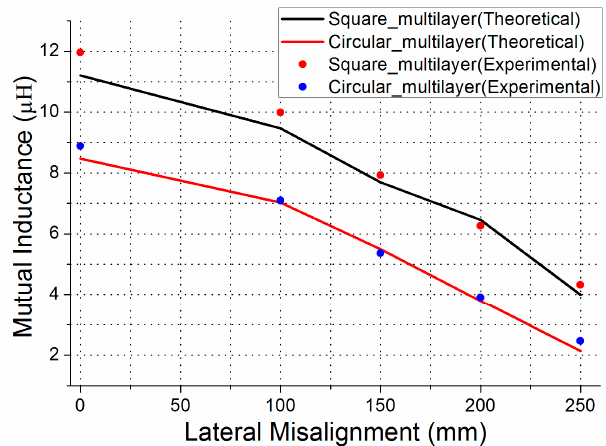
Figure 9. Mutual inductance of two coupling coils with multilayer media. Table 5. Mutual inductance comparison with lateral misalignment.